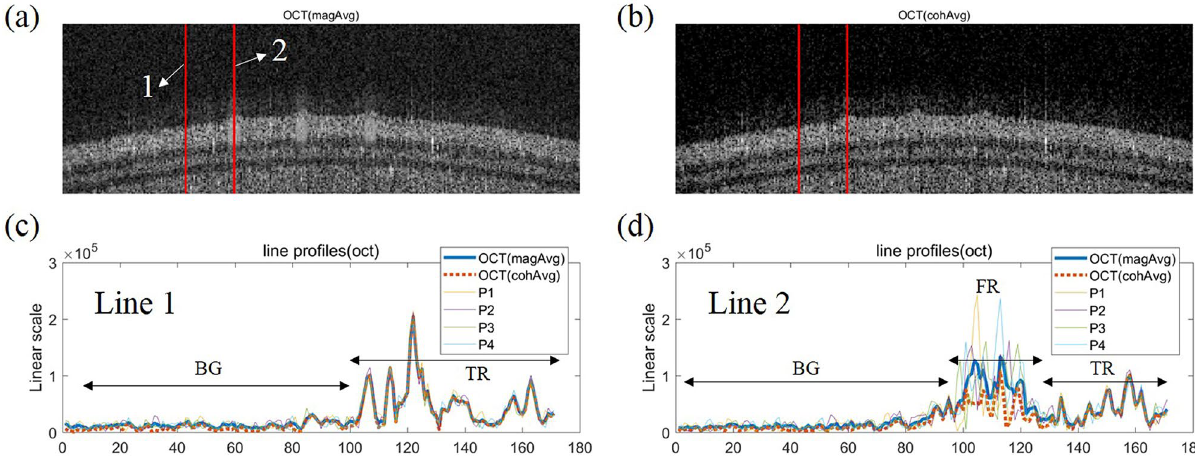
Figure 3. Comparison of OCT images for retina phantom obtained by magnitude averaging (magAvg) or coherent averaging (cohAvg). ( a ) OCT image applying magAvg. ( b ) OCT image applying cohAvg. ( c , d ) Profiles of lines number 1 and 2 drawn in the averaged OCT images ( a , b ) and four OCT images (P1–4) before averaging, respectively. BG, background region. TR tissue region, FR flow